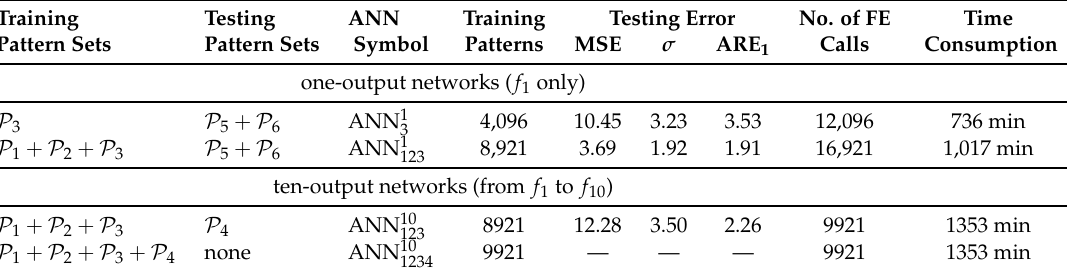
Table 10. Deep network training and testing results (three-segment MODEL2).